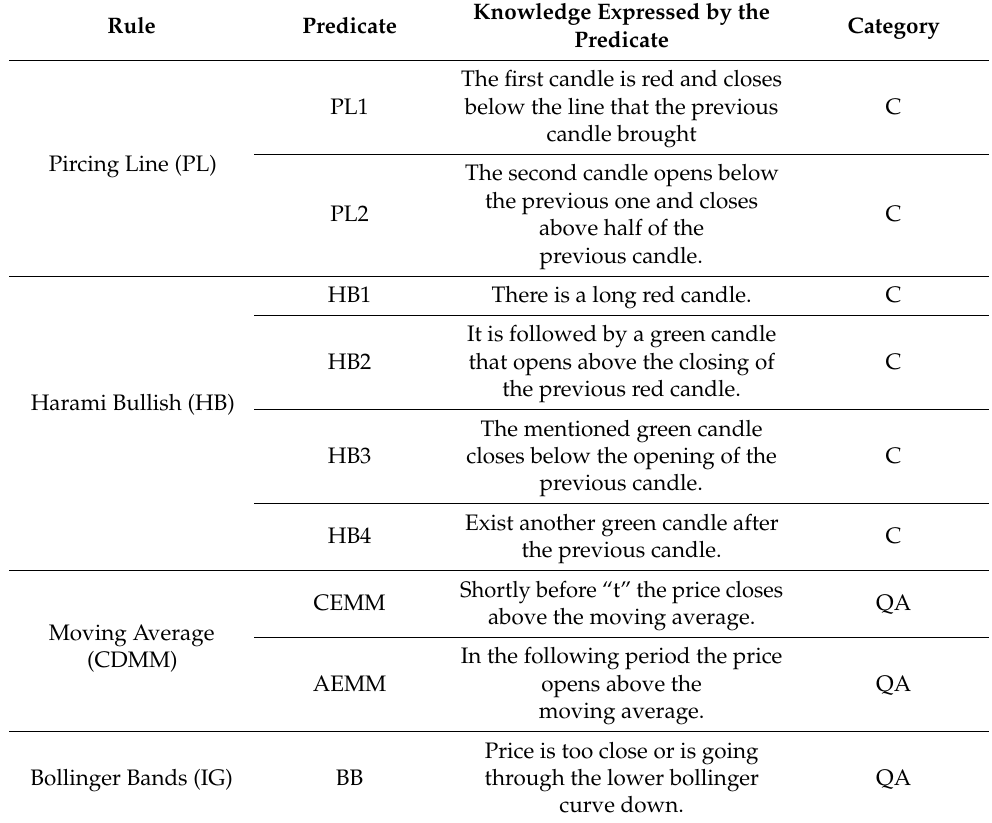
Bollinger Bands (IG)